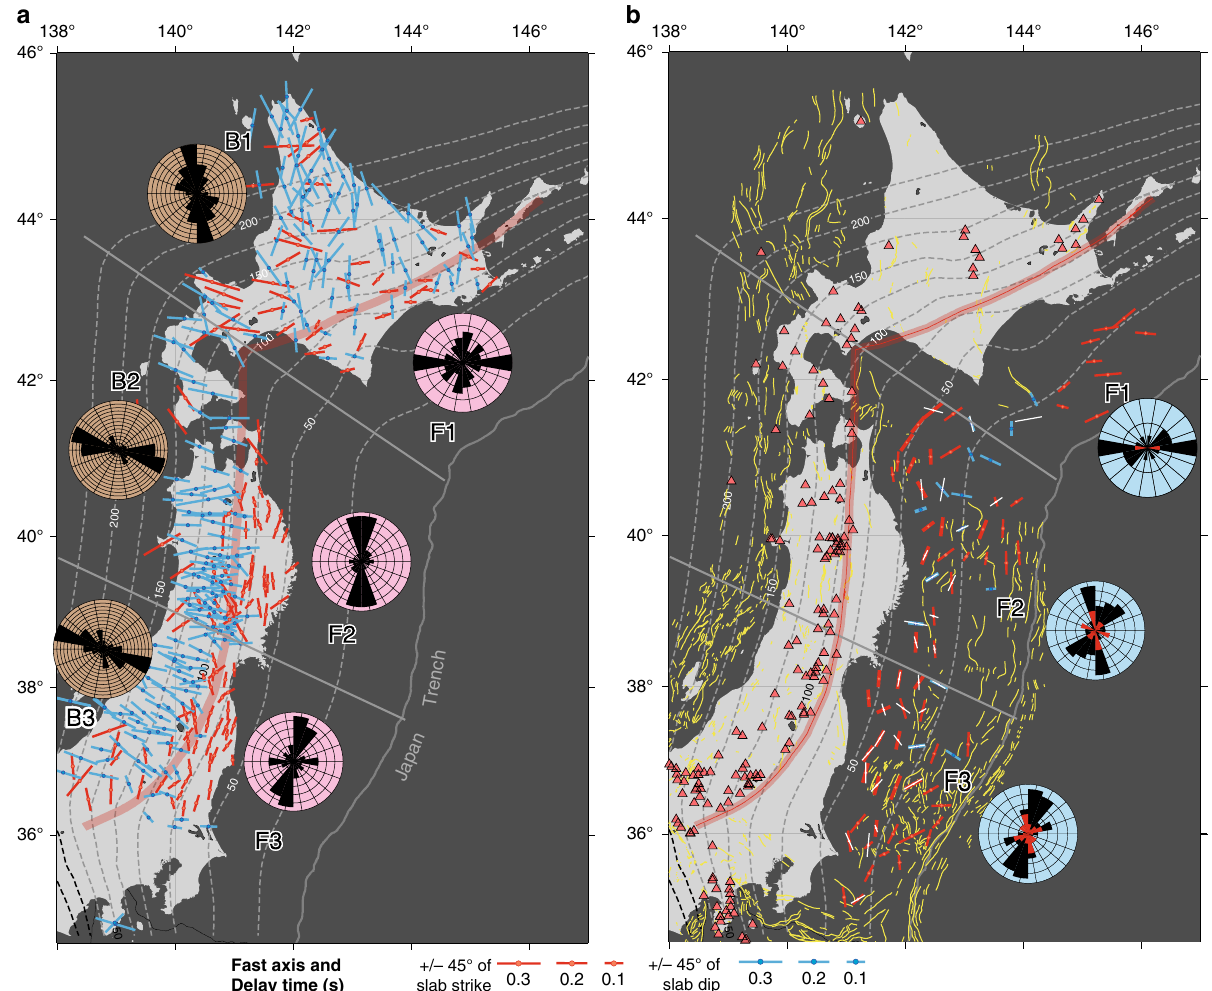
Fig. 2 Distribution of the splitting parameters along the Japan and Kuril trenches. ( a ) and ( b ) shows the fast direction (direction of the bars) and delay time (length of the bars) on land 17 and offshore, respectively. The averaged splitting parameters are plotted at each station. The color of bars indicate the direction is trench-parallel (red) or not (blue) for land intraplate and offshore interplate earthquakes. The results for offshore upper-plate earthquakes (depth ≤ 35 km) are shown in white. The thick bars offshore show the results estimated from ten or more earthquakes. The rose diagrams show the frequency distribution of the fast direction for the stations in areas F1 – F3 and B1 – B3 divided by the black lines, with blown, pink, and blue colors for the back-arc, onshore forearc, and offshore forearc areas, respectively. Black and red in the rose diagrams in ( b ) represent results for interplate and upper-plate earthquakes, respectively. The interval of the concentric circles in the rose diagrams is two. Black contours show the depth to the subduction interface in 25-km intervals 51,52 . Yellow lines show the active fault traces 45 . The volcanic front is marked by the thick pink